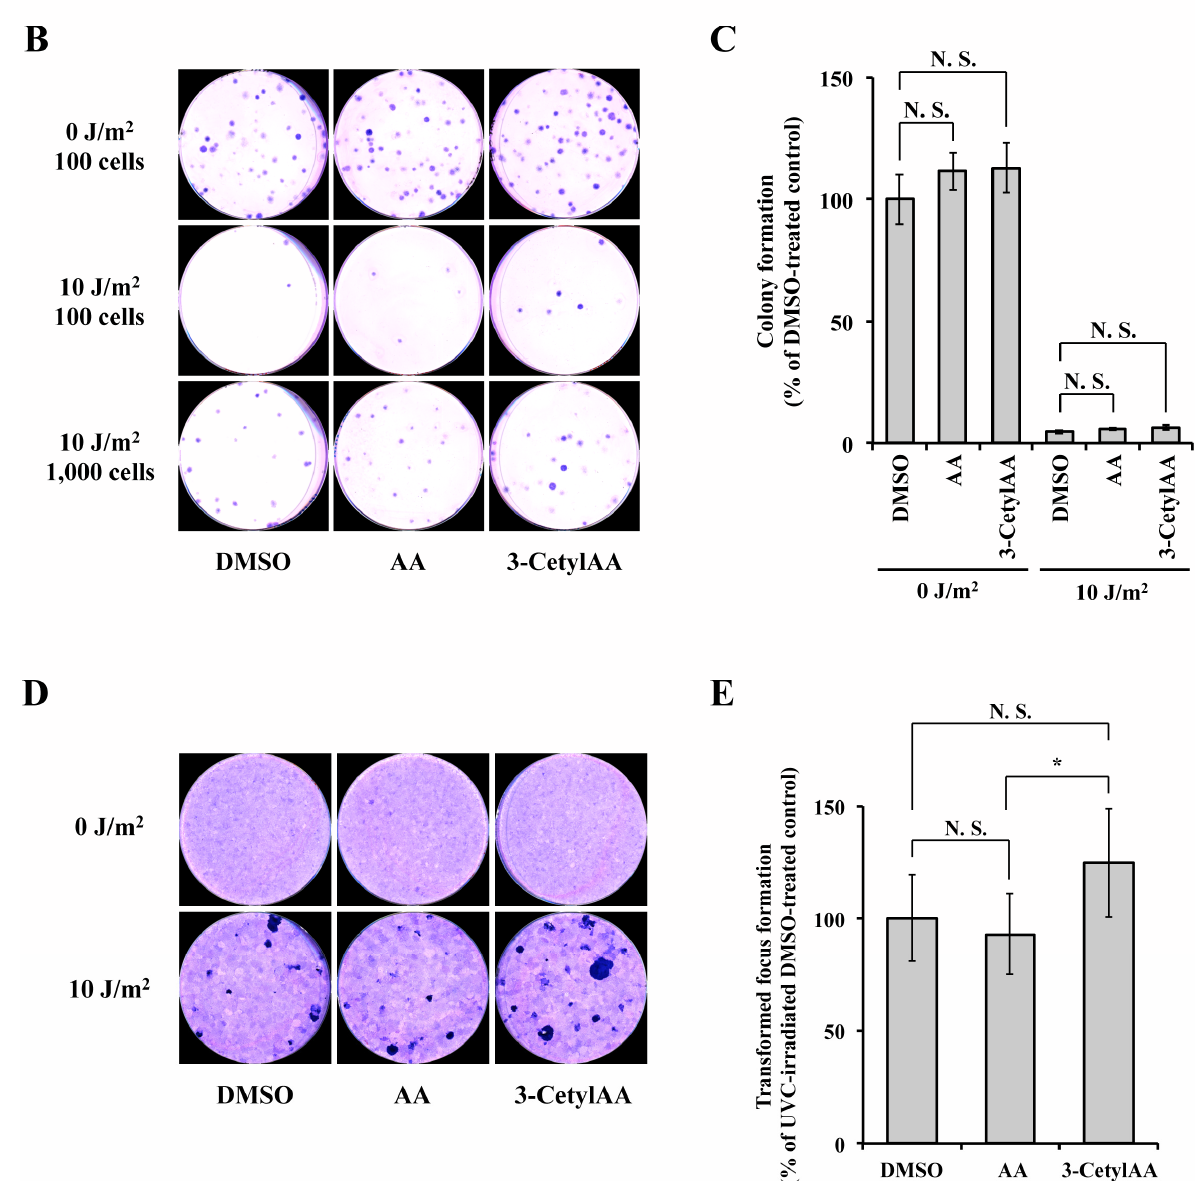
Figure 4. Effects of 3-CetylAA-induced cell killing and cell transformation and their UVC-induced potentiation effects: ( A ) Study design and treatment schedule. Exponentially growing BALB/c 3T3 A31-1-1 cells were used for clonogenic assay and transformation assay. ( B ) Depiction of colony formation on Giemsa-stained dishes from clonogenic assay. ( C ) Quantification of the number of colonies. The data were obtained from three independent experiments using triplicated dishes. Values indicate means ± S.E. N.S., not significant. ( D ) Depiction of transformed foci on Giemsa-stained dishes from transformation assay. ( E ) Quantification of the number of transformed foci as determined using standard criteria. The data were obtained from three independent experiments using 10 − 12 dishes. Values indicate means ± S.E. * Significant difference ( p < 0.03). N.S., not